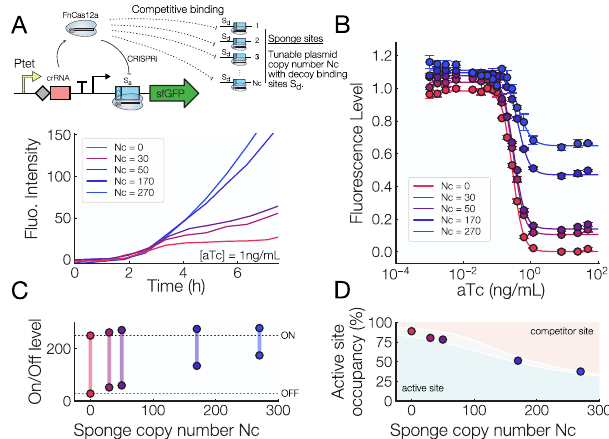
Fig. 6 Control of a CRISPRi inverter with competitor binding sites. A Top: Diagram showing how production of a dCas12a CRISPR RNA (crRNA) is controlled by an aTc-inducible promoter, and the dCas12a + crRNA duplex can either bind to the active site S a , which turns off production of sfGFP, or to a decoy site S d residing on a “ sponge ” plasmid. Bottom: Fluorescence intensity vs time for CRISPR-dCas12a systems with variable numbers of sponge sites (Nc). B Induction curves for a CRISPRi system with sponge sites on plasmid with varying copy numbers, n = 3 biological replicates for each data point. C ON-OFF levels for variable numbers of sponge sites. The ON and OFF fl uorescence level of the inverter both increase as the number of sponge sites varies from 0 to 270. The dynamic range decreases with increasing sponge copy number. D Active site occupancy vs number of sponge sites, as the number of sponge sites increases the active site becomes less occupied. The gray area represents the numerical solution of a fold-change model 15,35 for dCas12a where the binding energy equal to − 13.25 k B T (top) and − 12.25 k B T